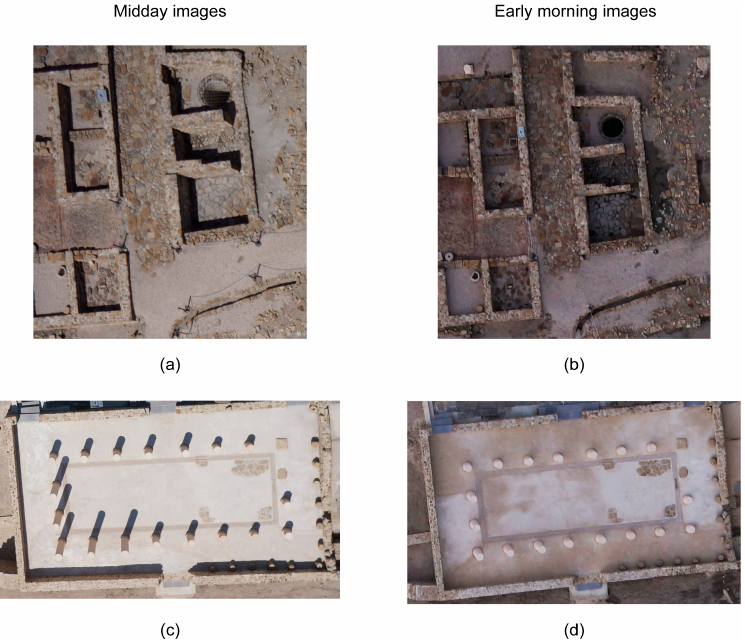
Figure 6. ( a – d ) The effects of illumination on images taken by UAV flights at midday ( a , c ) and early morning ( b , d ).